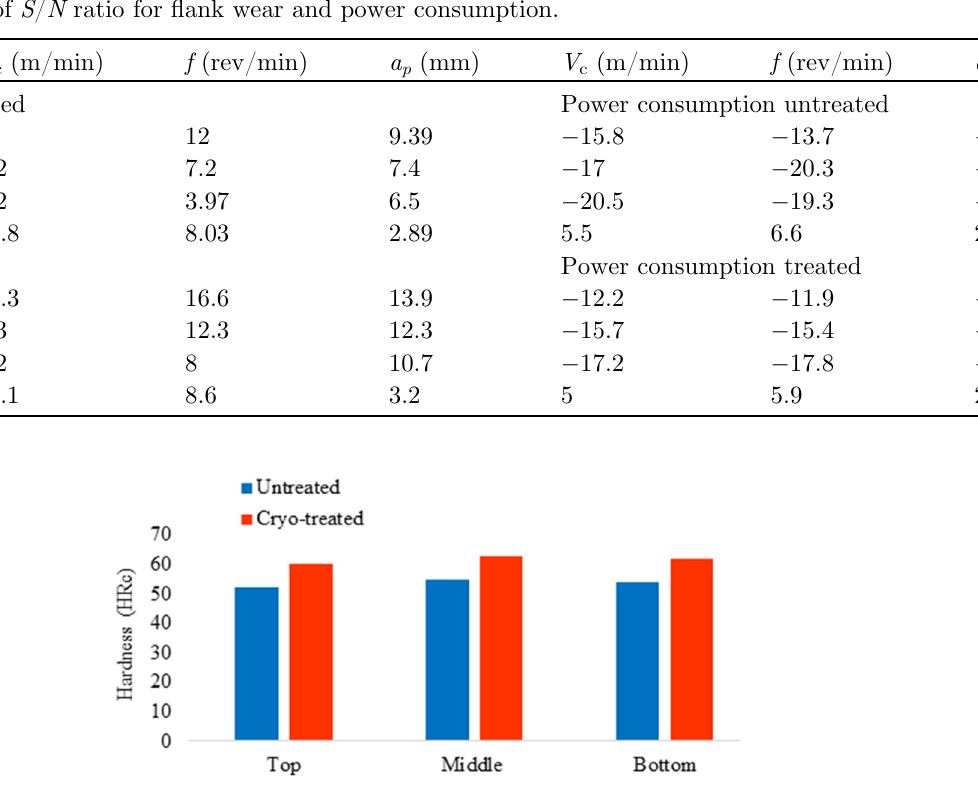
Fig. 6. Graph showing the change in hardness after DCT in comparison to untreated tool.